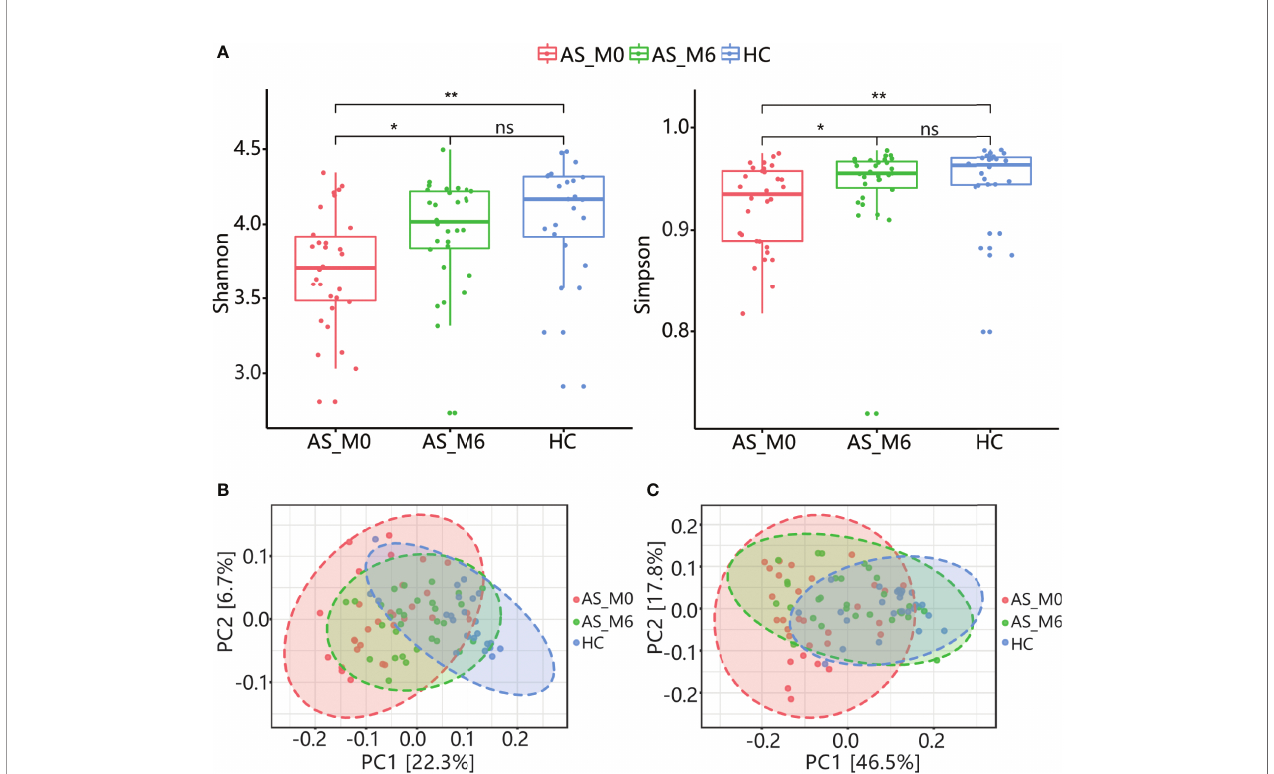
FIGURE 1 | Community structure of gut microbiota in AS patients and HCs. (A) a -diversity of gut microbiota (Shannon and Simpson index) among AS patients at baseline and after treatment and among HCs. The horizontal bar within each box represents the median. The bottom and top of each box represent the 25 th and 75 th percentiles, respectively. The upper and lower whiskers extend to data no more than 1.5 × the IQR from the upper and lower edges of the box, respectively. * P < 0.05, ** P < 0.01, ns, P > 0.05. PCoA plot based on the unweighted UniFrac distance (B) and weighted UniFrac distance (C) of gut microbiota from AS patients at baseline and after treatment and from HCs. AS, ankylosing spondylitis; AS_M0, AS patients at baseline; AS_M6, AS patients after treatment; HC, healthy control; IQR, interquartile range; PCoA, principal coordinates analysis.